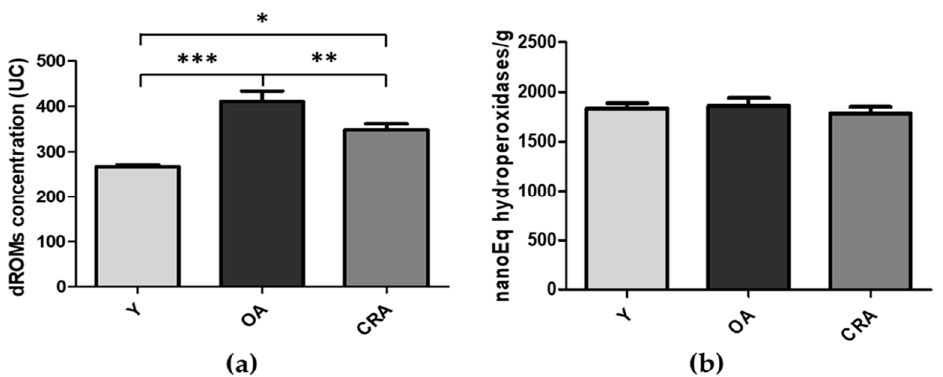
Figure 1. Plasmatic values of oxidative stress (d-ROMs) ( a ) and antioxidant capacity efficiency (BAP) ( b ) tests in young rats (Y), obese aged (OA), and aged undergoing calorie restriction (CRA)rats. Data are means ± SE of five determinations for each animal ( n = 6). Statistical differences were evaluated by one-way ANOVA, followed by Bonferroni’s multiple comparison test (* p < 0.05; ** p < 0.001; *** p < 0.0001).